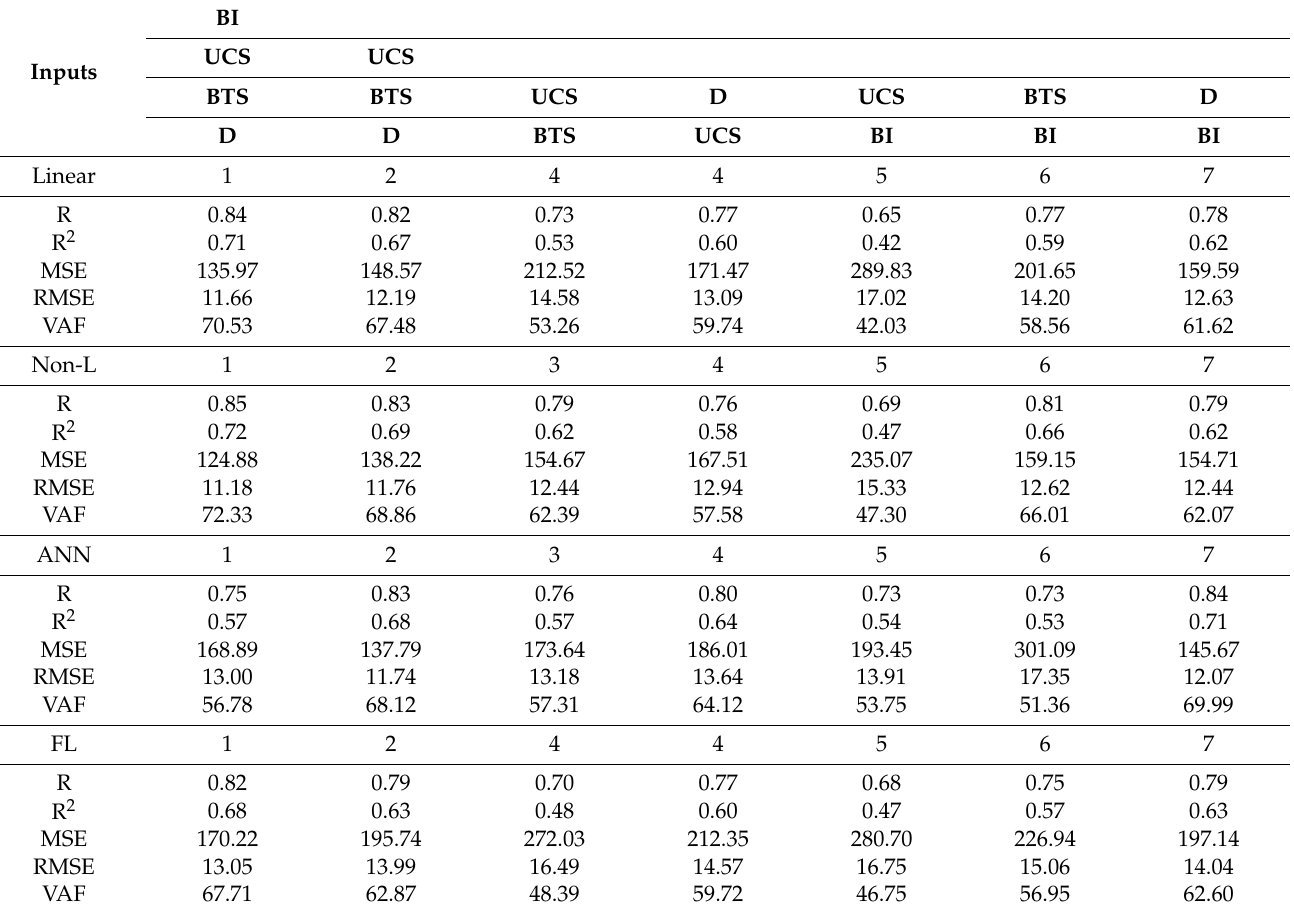
Table 14. Comparison of accuracy of the models based on obtained statistical performance